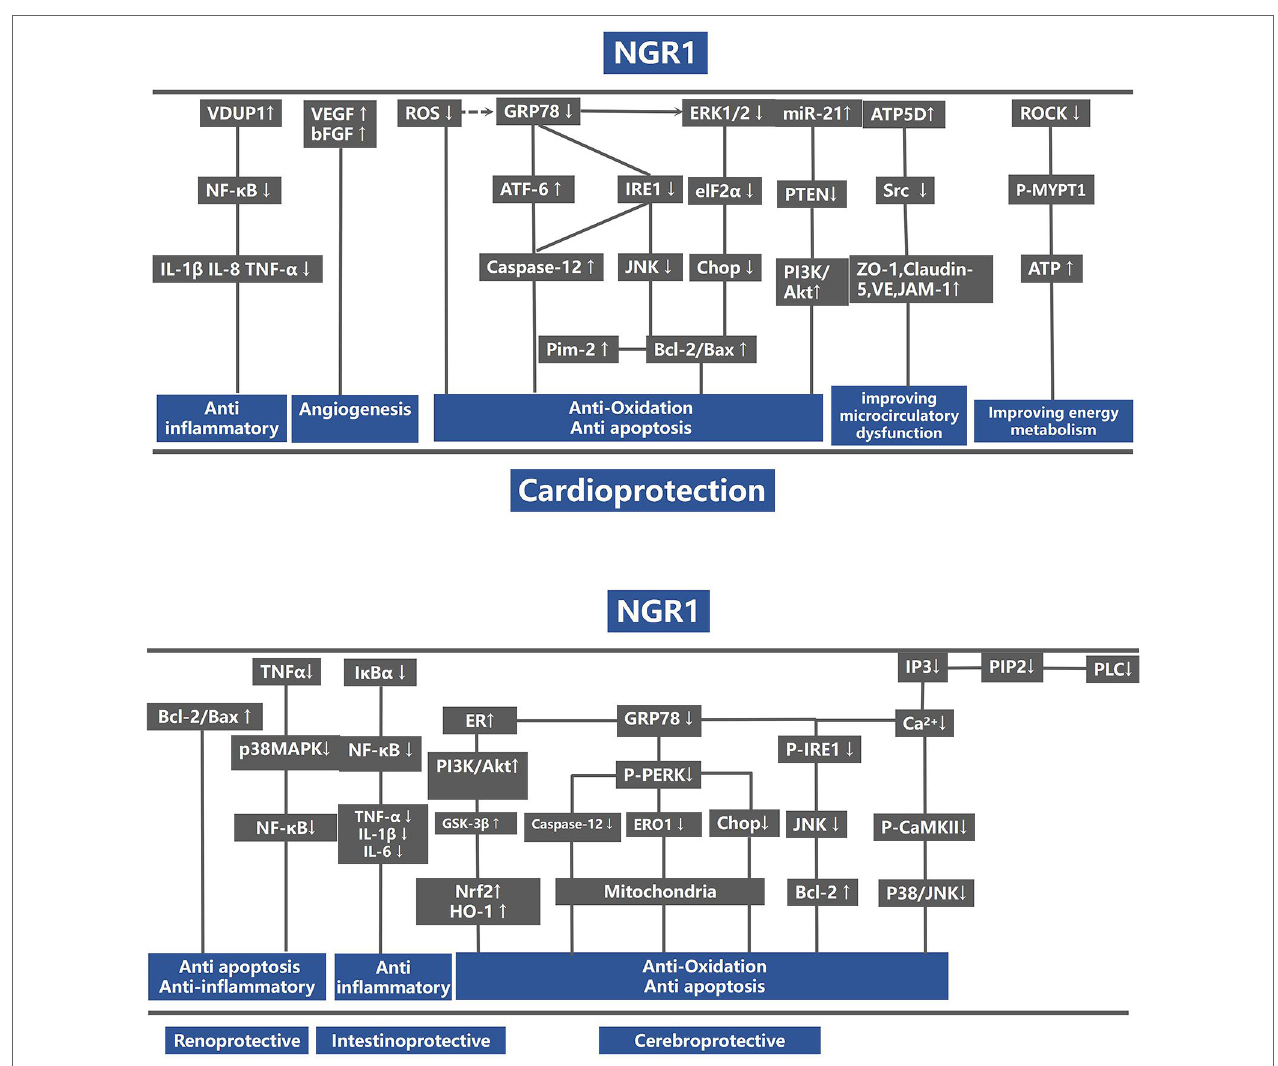
FIGURe 10 | A schematic representation of cardioprotective mechanisms of NGR1 for organs ischemia/reperfusion injury. VDUP1, vitamin D3 up-regulated protein 1; NF- κ B, nuclear factor-kappa; IL-1, interleukin-1; IL-1 β , interleukin 1 beta; IL-8, interleukin-8; TNF- α , tumor necrosis factor- α ; VEGF, vascular endothelial growth factor; bFGF, basic fibroblast growth factor; GRP78, glucose regulated protein 78; PERK, protein kinase R-like ER kinase; ATF-6, activating transcription factor 6; IRE1, inositol-requiring enzyme-1 α ; JNK, Jun N-terminal kinase; CHOP, C/EBP homologous protein; B-cell lymphoma-2; Bax, BCL2-associated X protein; eIf2 α , eukaryotic initiation factor 2 α ; PTEN, phosphatase and tensin homolog deleted on chromosome ten; PI3K, p-mTOR, phospho-mammalian target of rapamycin; ZO-1, Zonula occludens-1; JAM-1, recombinant junctional adhesion molecule 1; Cav-1, caveolin 1; Cav-3, caveolin 3; MYPT1, myosin phosphatase target subunit-1; ATP, adenosine triphosphate; ROCK, Rho-associated kinase; GSK-3 β , glycogen synthase kinase-3 beta; I κ B α , nuclear factor of kappa light polypeptide gene enhancer in B-cells inhibitor; alpha; HO-1, heme oxygenase-1; Nrf2, nuclear factor erythroid 2-related factor 2; IP3, inositol 1, 4, 5-trisphosphate; PLC, phospholipase C.